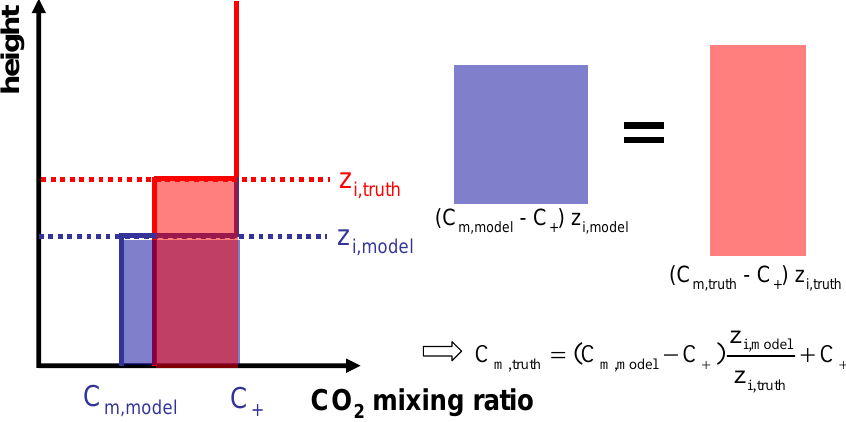
Fig. 2. Idealized CO 2 profiles in a column of air with unit area. A model with weak vertical mixing (blue lines) has a lower mixing height ( z i, model ) than the truth ( z i, truth , red lines). The shaded areas represent the mixed layer column mass assuming a constant air density profile. The reshuffling method (Eq. 1) scales the modeled ML CO 2 such that the column mass is